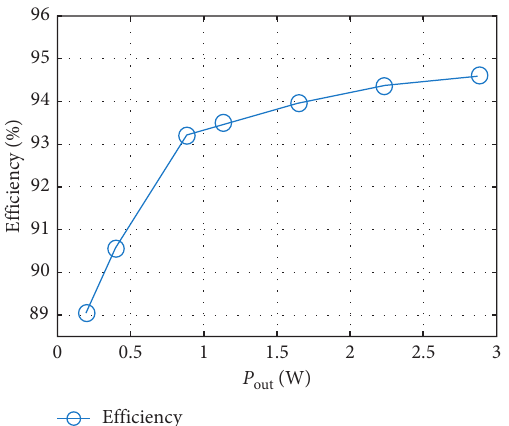
Figure 17: Efficiency versus output power at a 4 Ω load.